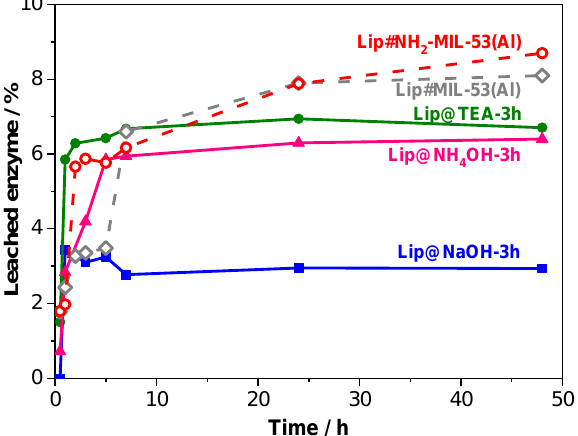
Figure 4. Percentage of lipase leaching along the time for different post-synthesis (dashed lines, empty symbols) and in situ (solid lines, full symbols) biocatalysts.